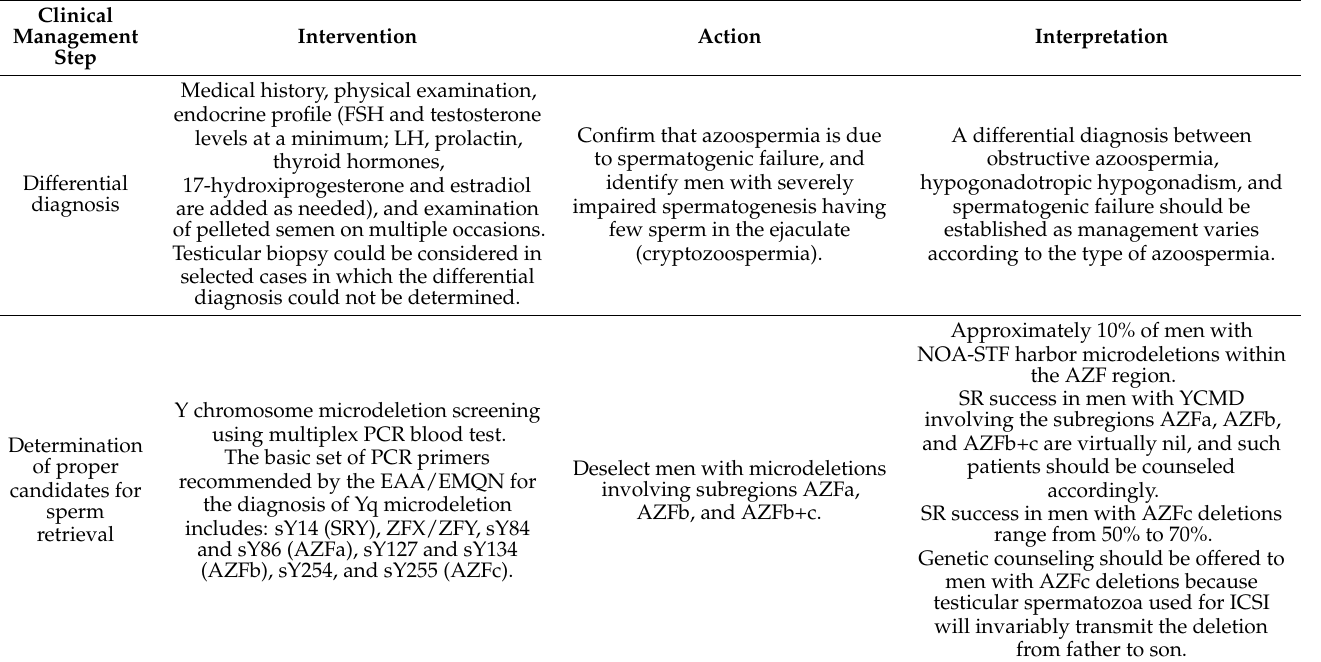
Table 2. Interventions and recommended actions in the clinical management of azoospermic men with nonobstructive azoospermia seeking